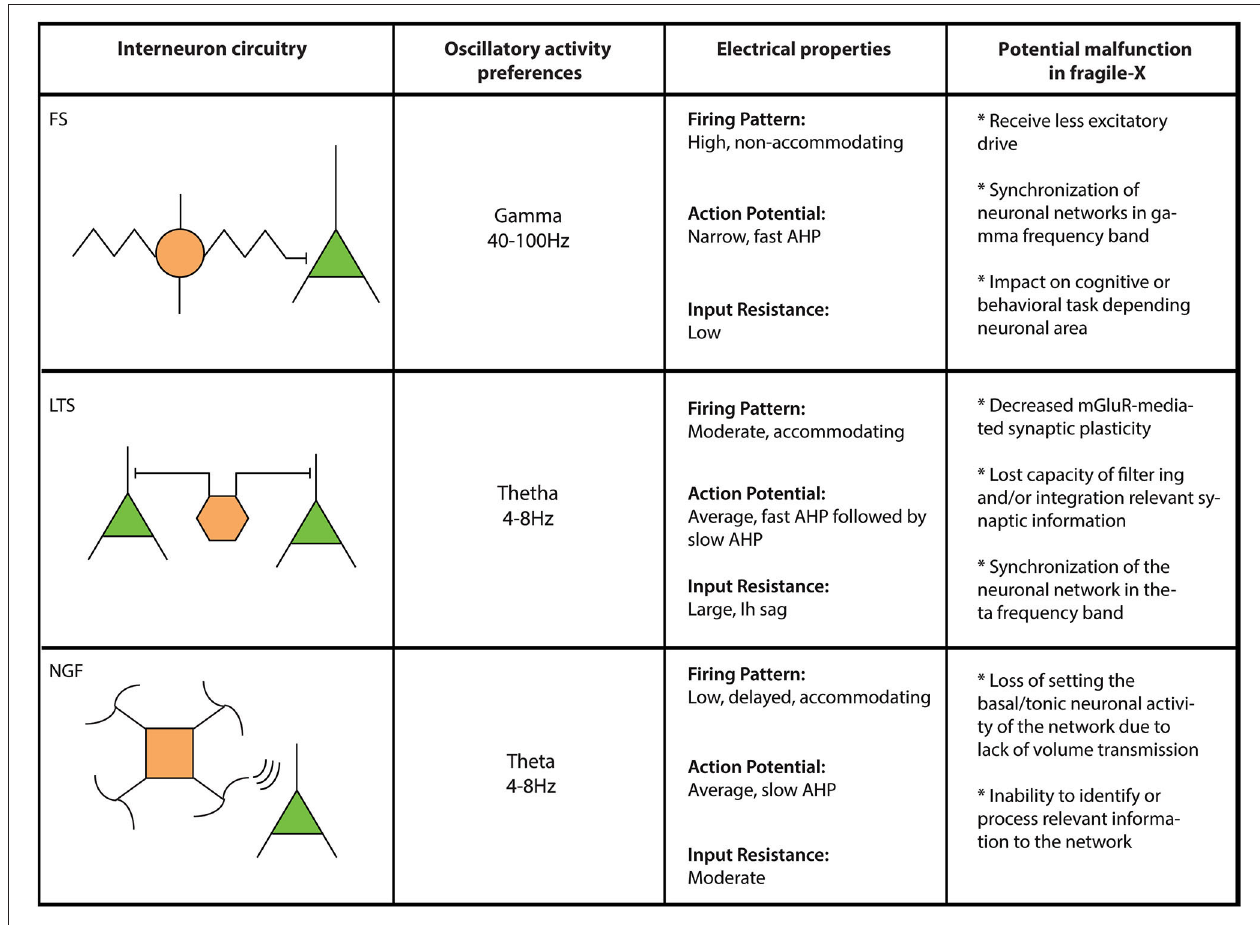
circuitry/connectivity (left panel), oscillatory preferences (left middle panel), electrical properties (right middle panel) and what their failure would represent in FXS (right